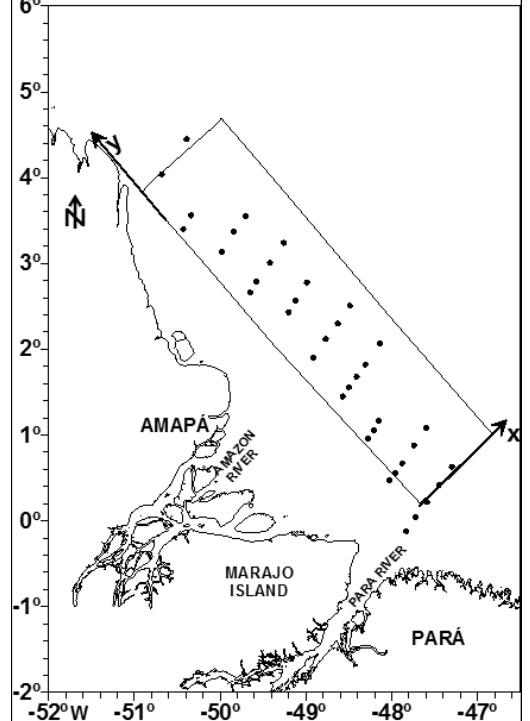
Fig. 2 – Map of the stations of the REVIZEE Program, and the inte- gration domain used in the simulations with